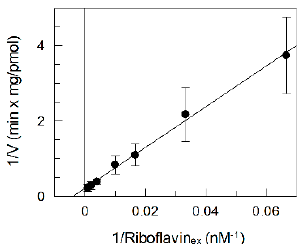
Figure 4 . Dependence of the riboflavin transport on substrate concentration. [ 3 H]Riboflavin was added to proteoliposomes at the indicated concentration. The transport measurement was stopped after 15 min. Data were plotted according to the Lineweaver–Burk equation. The values are means ± SD from three